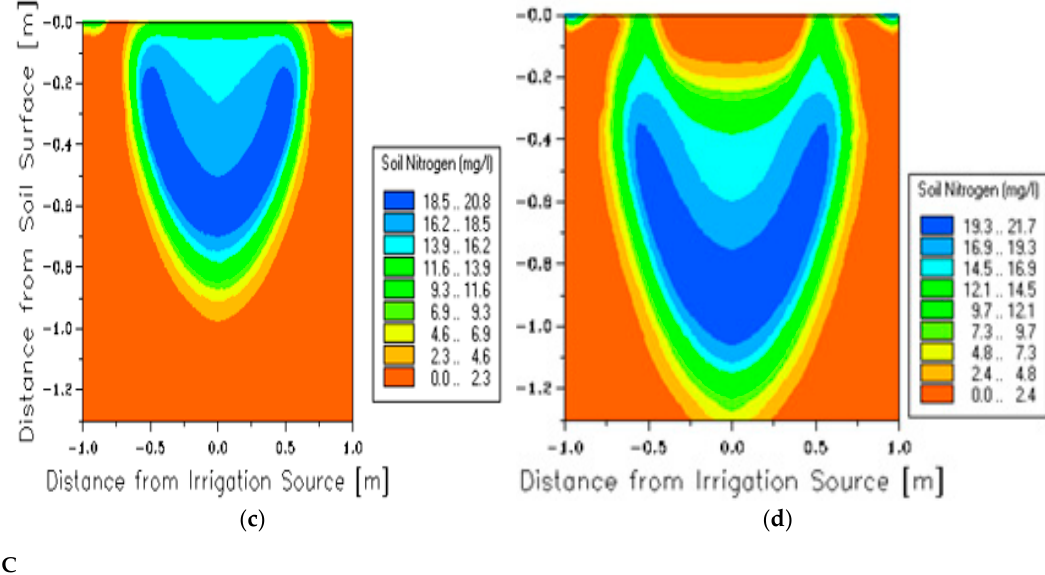
Figure 3. A ( a – d ). The distribution of soil moisture, through stages ( a – d ) of growth in the soil profile under partial root drying for potato crops at 150% of ETc, produced by SALTMED model version 2020. B ( a – d ). The distribution of soil salinity through stages ( a – d ) of growth in the soil profile under